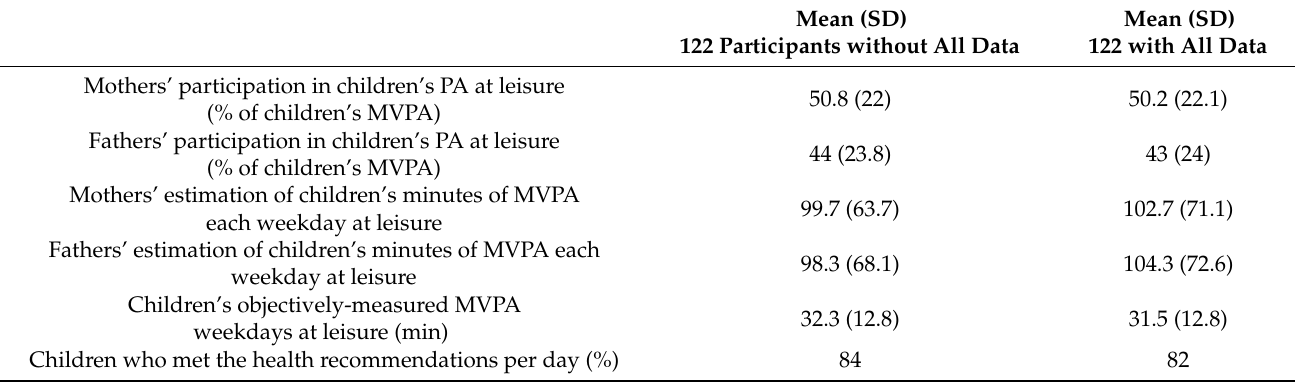
Table 2. Descriptive characteristics of the